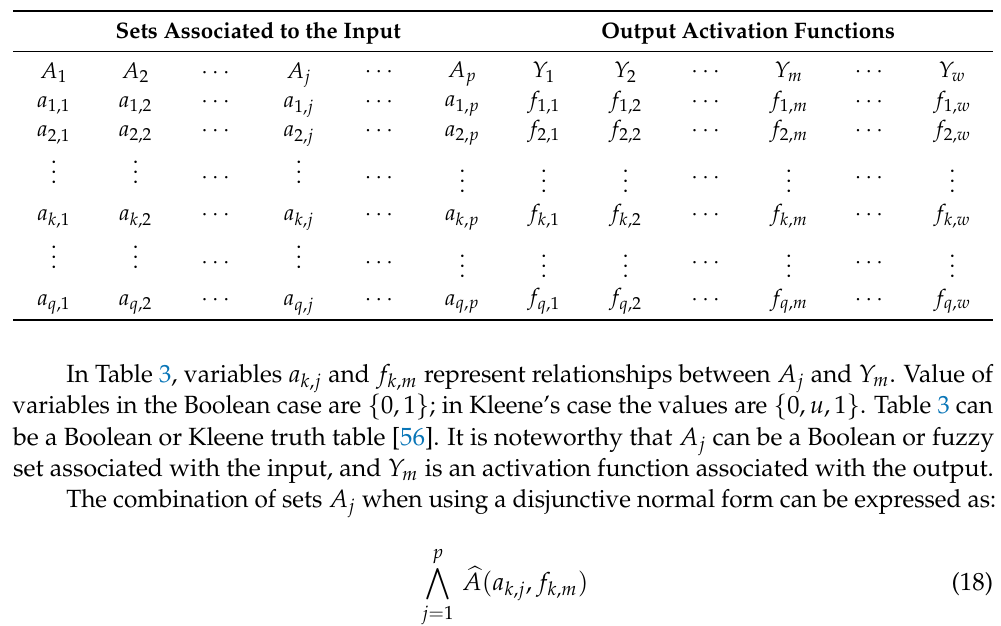
Table 3. Truth table with rules and activation